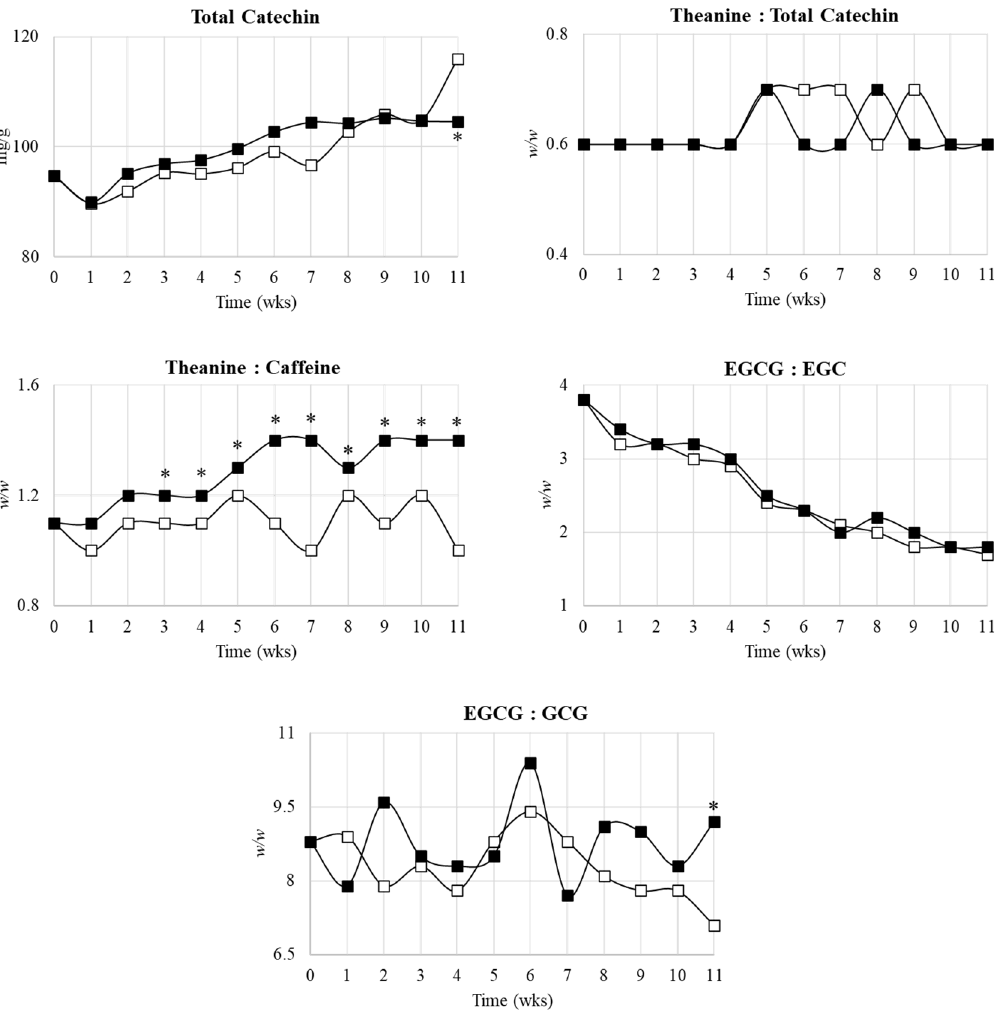
Figure 2. Line graph of mean effect on the concentration of quality markers of green tea grown in different light conditions over 11 weeks. An asterisk indicates a significant difference ( p < 0.05) between plants grown in reduced light intensity (black square: 90% opacity) vs. full ambient sunlight (white square) at the same study week.